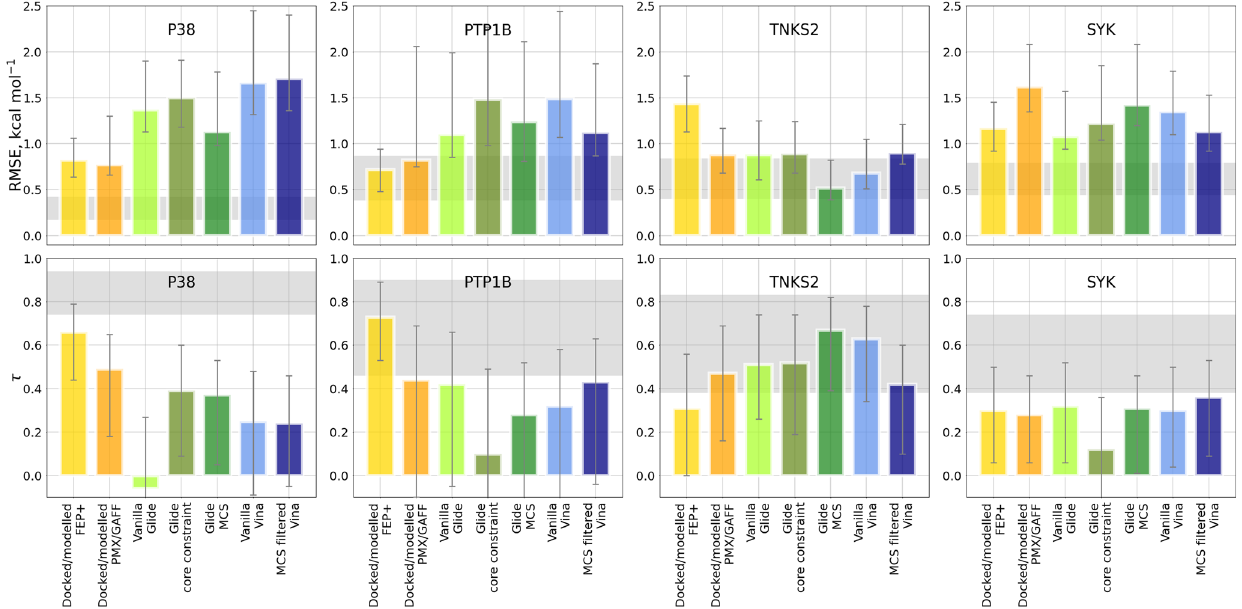
Fig. 5 RMSE and Kendall ’ s τ for each docking method on each of the four tested systems. Shaded regions represent 95% con fi dence intervals for RMSE and τ of the experimentally measured values based on the experimental uncertainty. For the cases where experimental uncertainty was not available (PTP1B, TNKS2, SYK), a lower bound for uncertainty of 0.43 kcal mol − 1 as suggested by the best practices was used 47 . Error bars denote 95% con fi dence intervals for the calculated values.